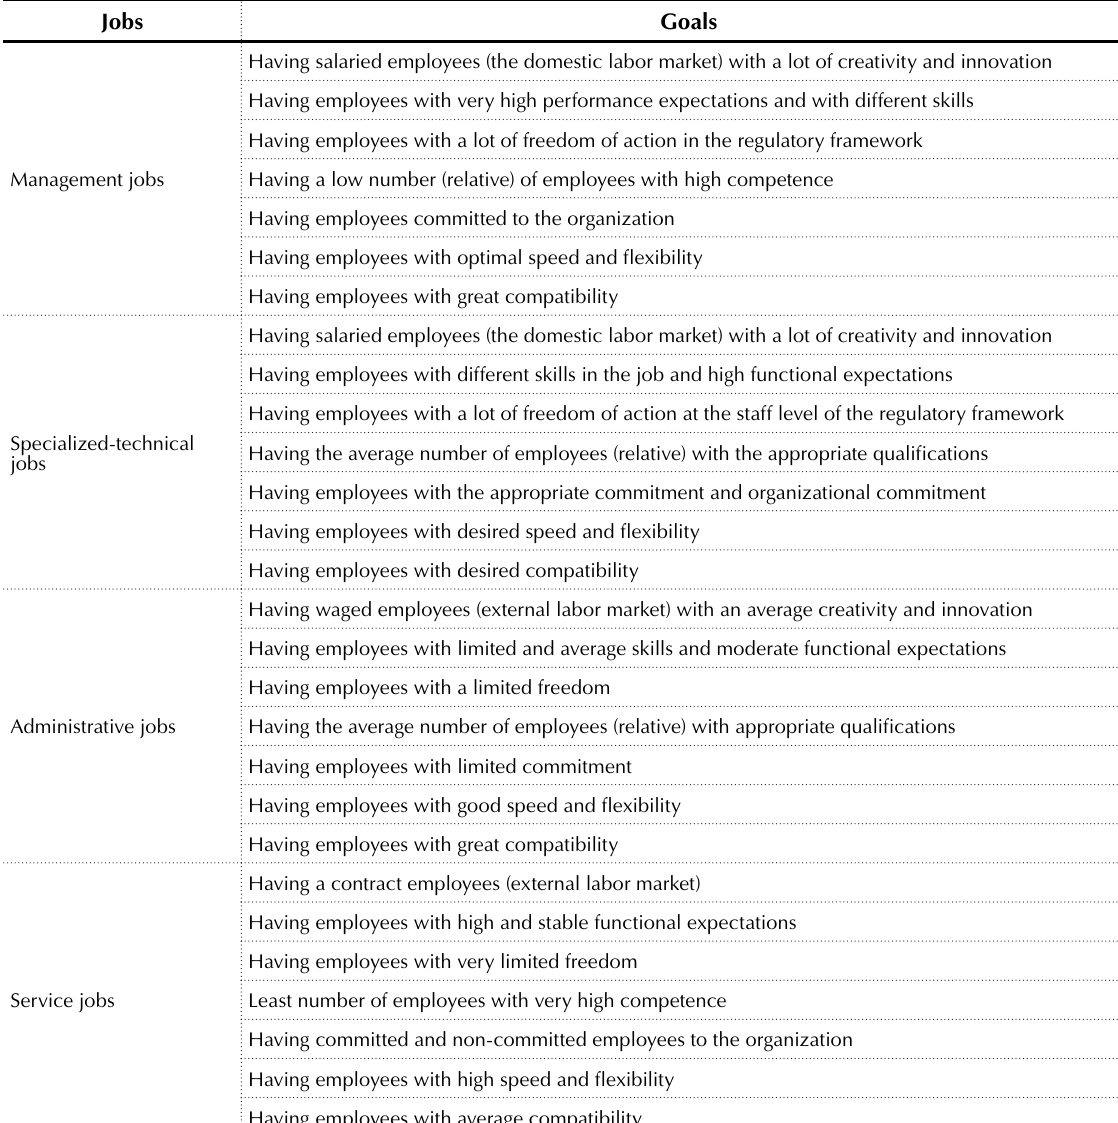
Table 8. Strategic objectives of human resource jobs in the Civil Deputy of the Isfahan Municipality